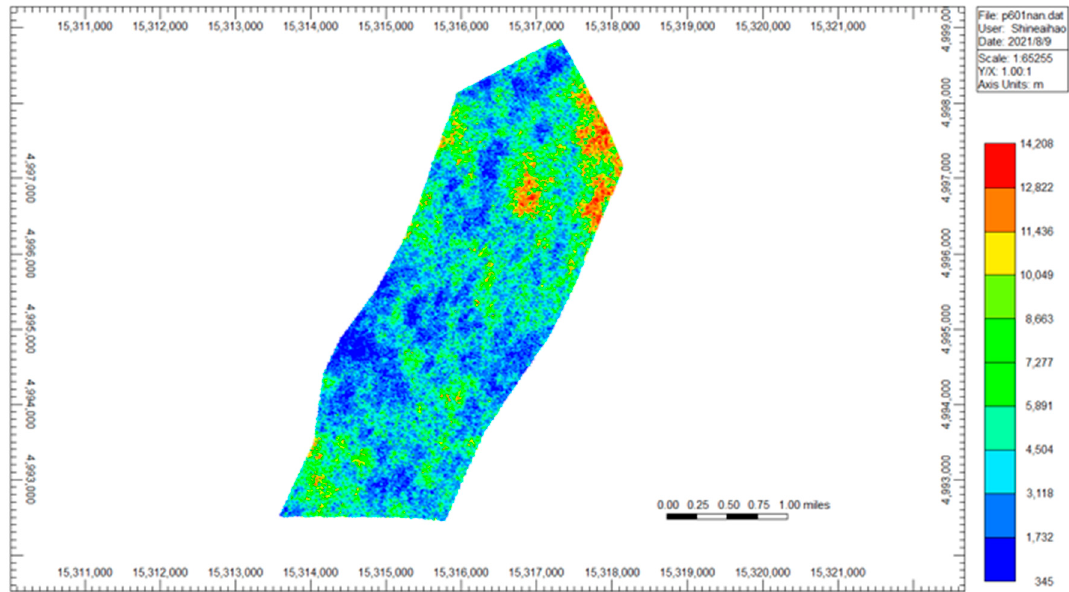
Figure A3. Permeability of numerical simulation model.